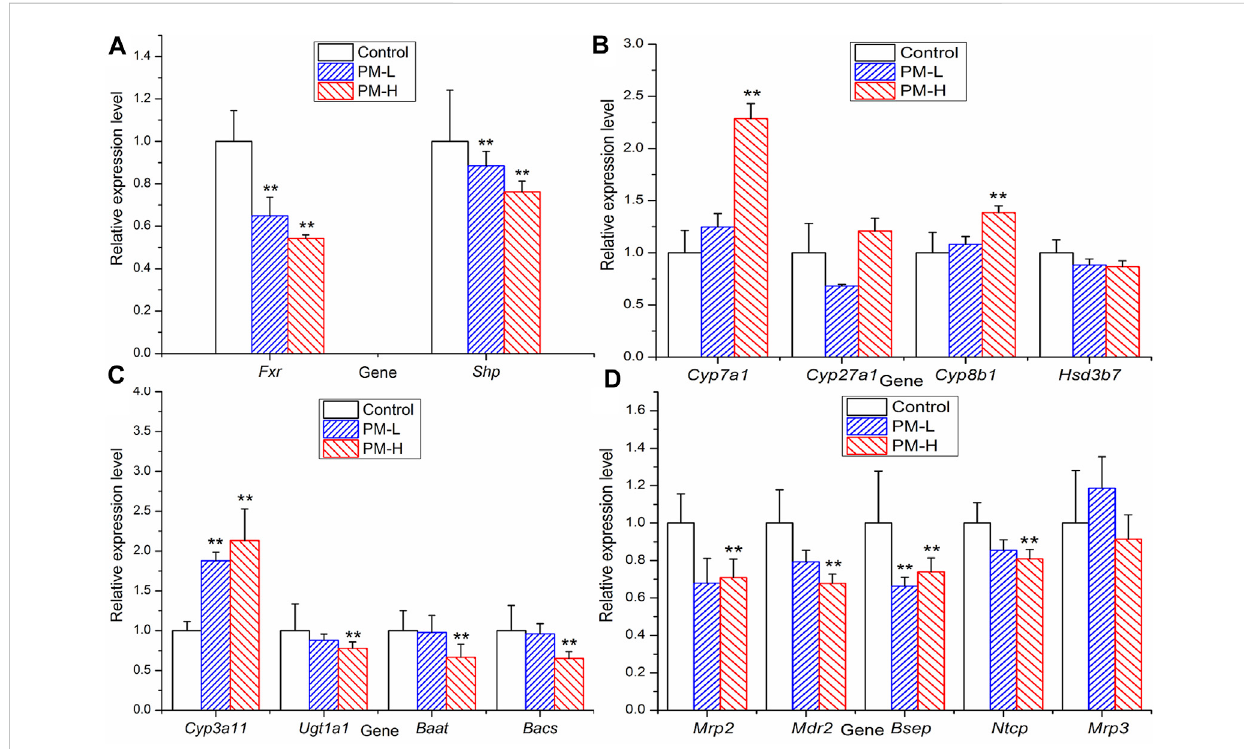
FIGURE 7 Relativeexpressionoftranscriptionfactor (A) ,metabolicenzyme (B,C) andtransporters (D) genesinmiceafter8 weeksadministration(X±SEM, n = 6, * p < 0.0, ** p <